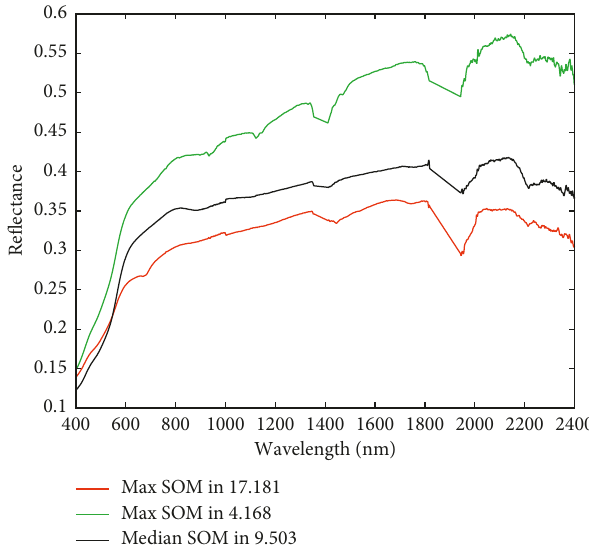
Figure 1: Spectral reflectance curve of different organic matter